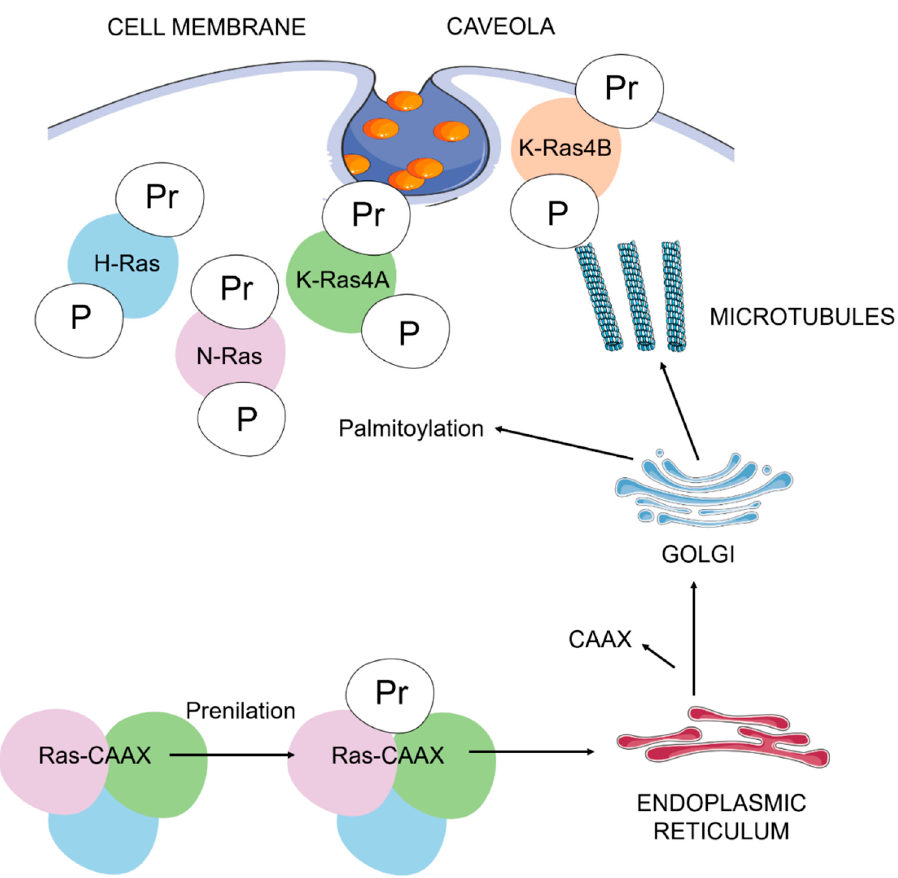
Figure 1. Ras post-translational modifications and trafficking to the plasma membrane. The addition of the carboxyl-terminal prenyl group is mediated by farnesyl or geranylgeranyl transferases. Inside the endoplasmic reticulum, several enzymes catalyze the removal of the AAX residues and the carboxyl methylation of prenylated cysteine residues. Palmitoylation of cysteine residues in H-Ras, N-Ras and K-Ras4A are necessary to complete, via the Golgi complex, their binding to cholesterol-rich plasma membrane pits (lipid rafts, caveola). An unknown pathway completes the binding of K-Ras4B (with a polybasic domain constituted by a lysine-rich sequence) to the plasma membrane. A: aliphatic amino acid; C: cysteine; P: palmitoyl group; Pr: prenyl group; X: serine or methionine. We represent H-Ras in blue, N-Ras in purple, K-Ras4A in green and K-Ras 4B in red.